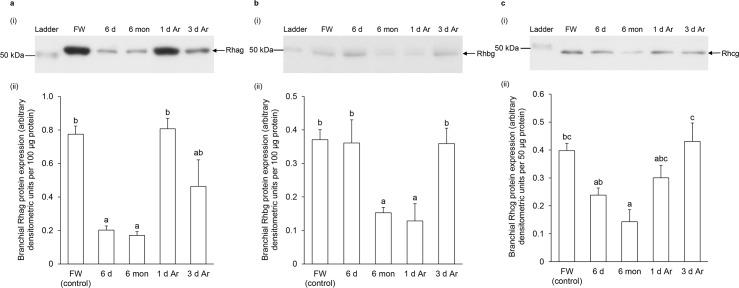
Protein abundance of Rhesus glycoproteins in the gills of Protopterus annectens.Protein abundance of (a) Rhesus blood group-associated glycoprotein (Rhag), (b) Rhesus family B glycoprotein (Rhbg) and (c) Rhesus family C glycoprotein (Rhcg) in the gills of Protopterus annectens kept in fresh water on day 0 (FW; control), or after 6 days (d; the induction phase) or 6 months (mon; the maintenance phase) of aestivation, or after 1 or 3 d of arousal (Ar; the arousal phase) from 6 mon of aestivation. (i) Examples of immunoblot of Rhag, Rhbg or Rhcg. (ii) The protein abundance of Rhag, Rhbg or Rhcg expressed as arbitrary densitometric units per 100 μg, 100 μg or 50 μg protein, respectively. Results represent mean ± S.E.M. (N = 4). Means not sharing the same letter are significantly different (P<0.05).